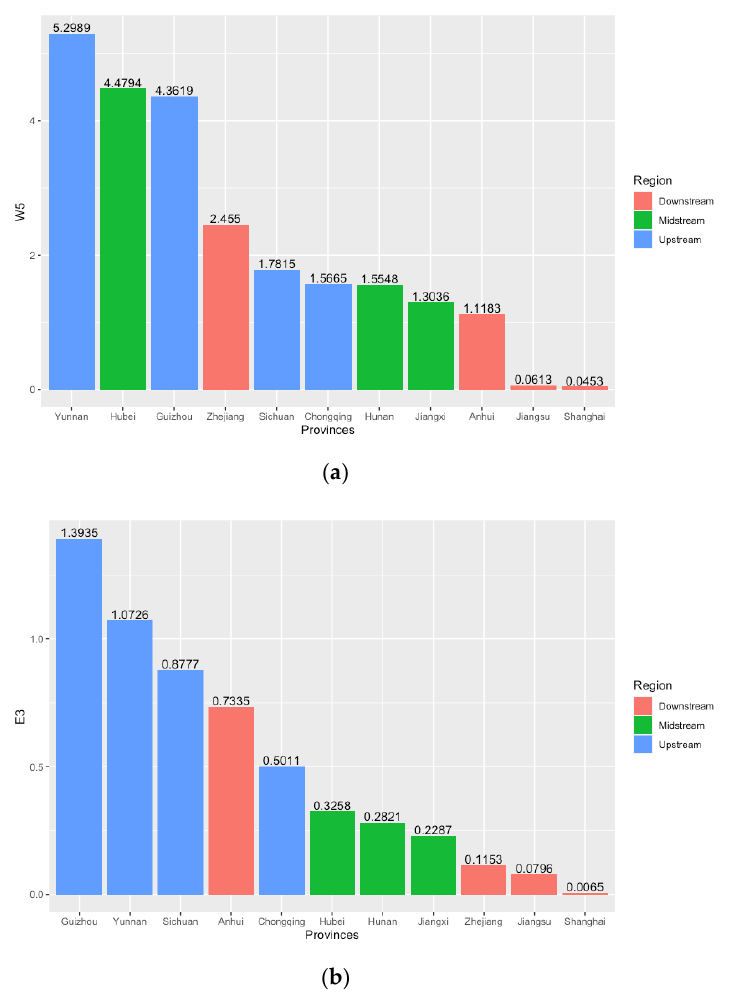
Figure 10. Comparison chart of key indicators of green security areas: ( a ) comparison of water conservancy project storage capacity (W5); ( b ) comparison of energy self-sufficiency rate (E3).